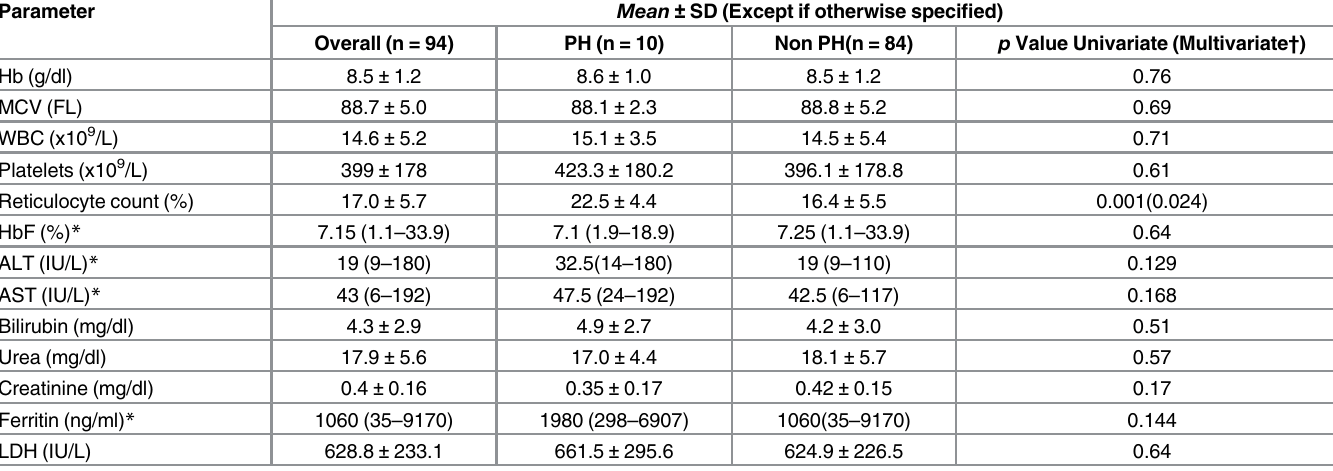
Table 2. Laboratory parameters in enrolled patients and a comparison between PH and non-PH